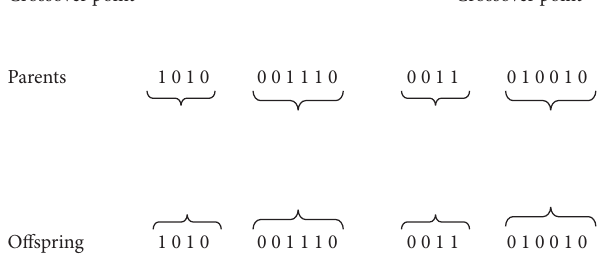
Figure 7: Single—Point cross